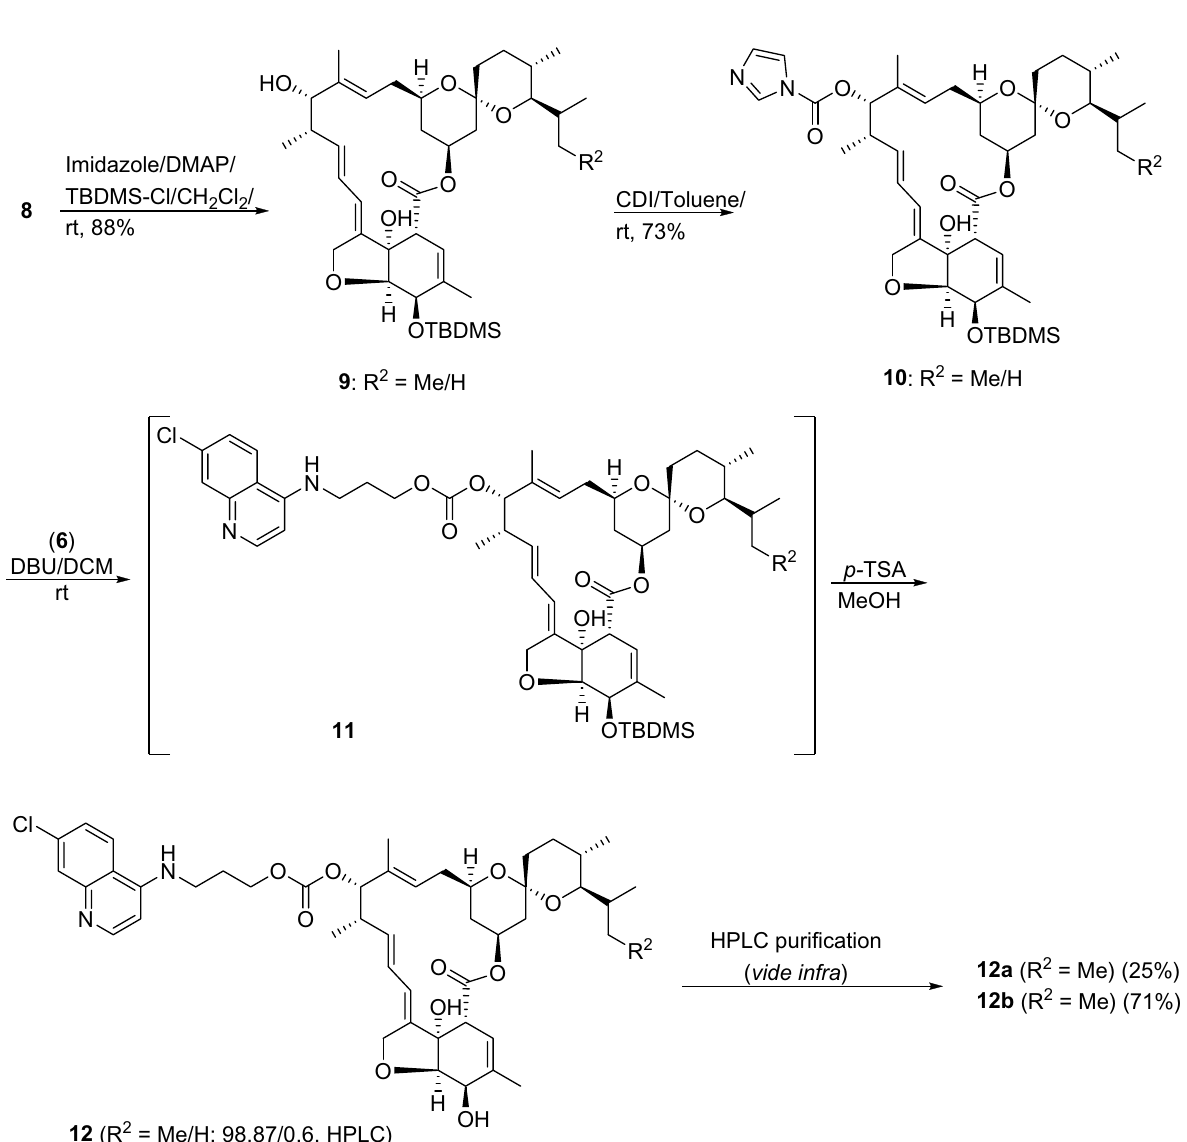
Figure 2. Synthesis of IVM-CQ conjugates 12 from 8